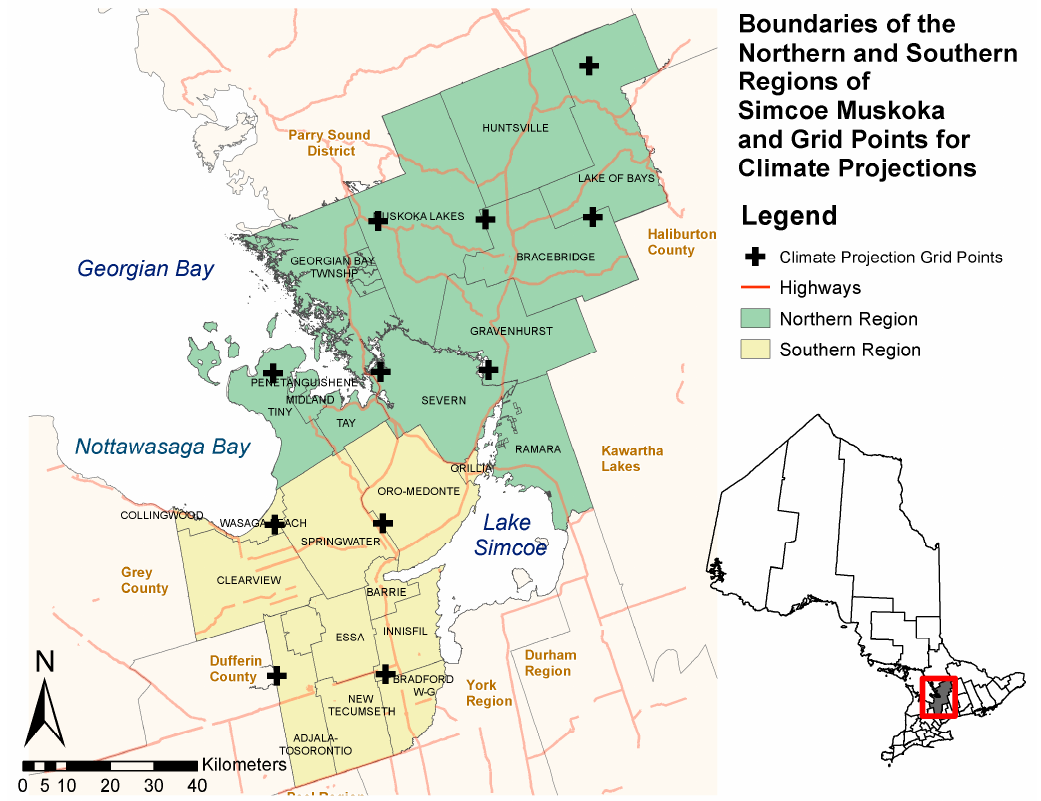
Figure 1. Simcoe Muskoka District Health Unit (SMDHU), Northern and Southern region boundaries and grid points for Ontario climate change portal climate projections [37], adapted from [17].